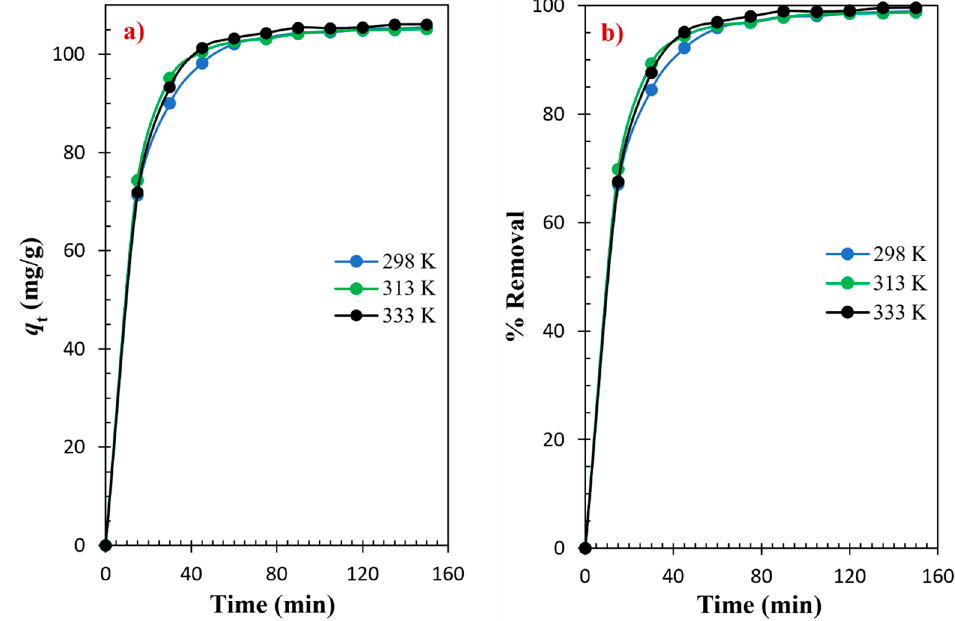
Figure 11. Time dependence of adsorption of MB onto rGO at different temperatures: ( a ) adsorption capacity and ( b ) removal efficiency (conditions: C MB0 = 20 mg/L, V = 100 mL, W rGO = 15 mg).